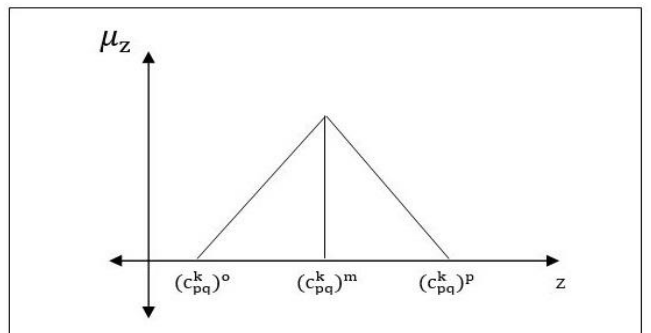
Figure 1. Triangular possibilistic